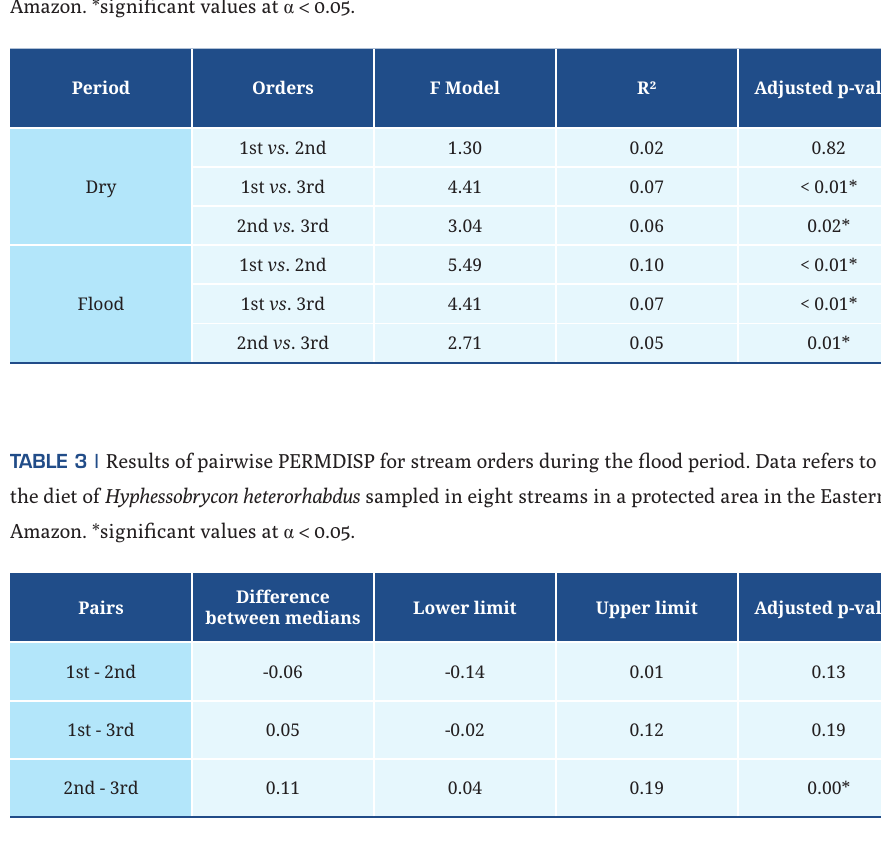
TABLE 2 | Results of pairwise PERMANOVA for stream orders nested within periods. Data refers to the diet of Hyphessobrycon heterorhabdus sampled in eight streams in a protected area in the Eastern Amazon. *significant values at α < 0.05.